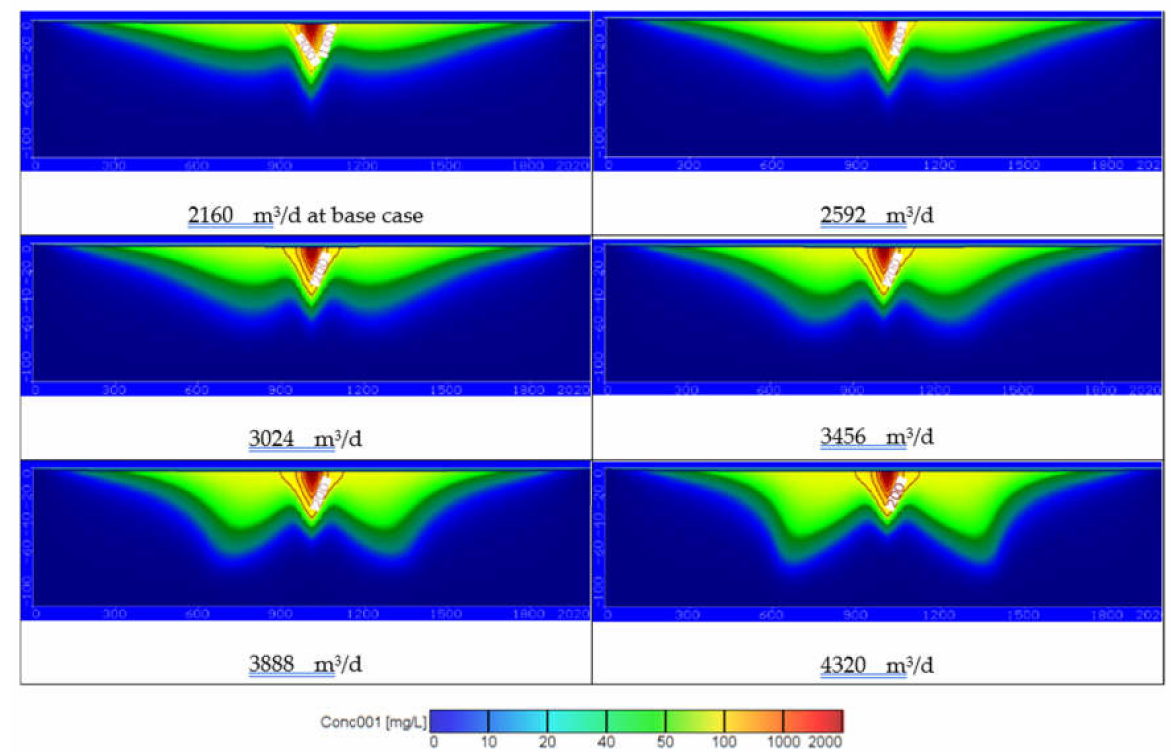
Figure 6. The distribution of COD in groundwater contamination for different pumping